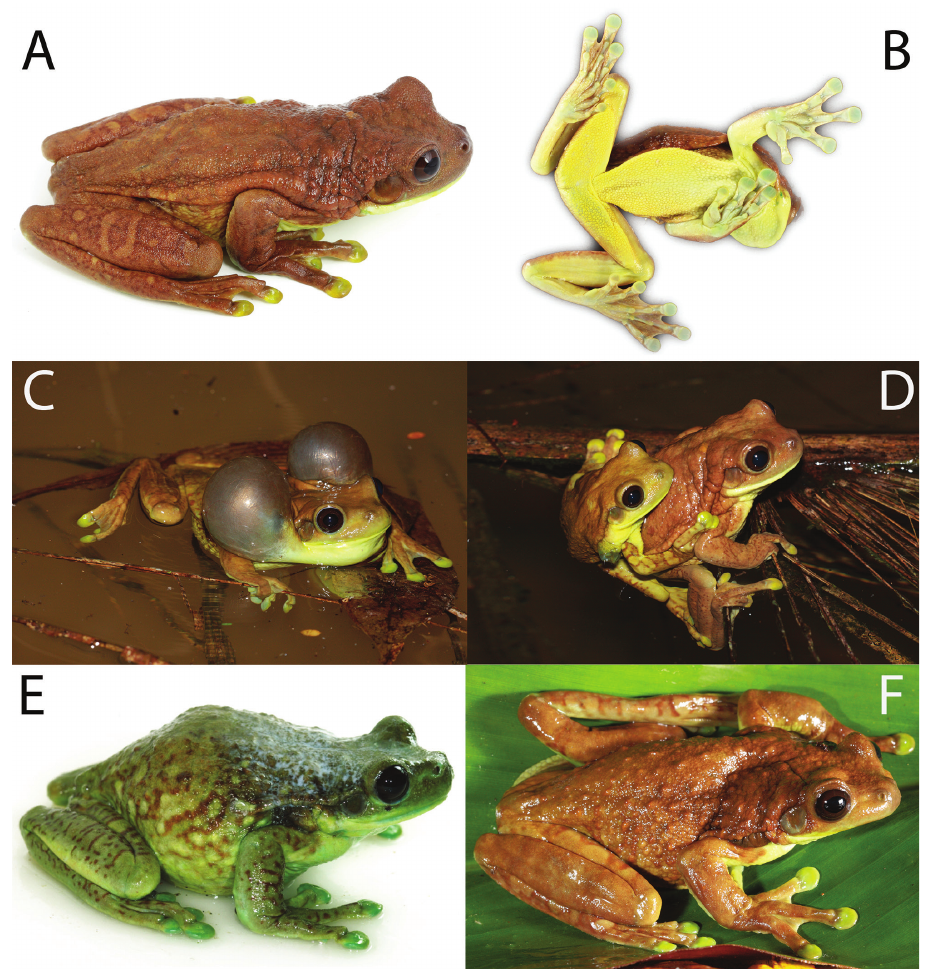
Figure 12. External morphology of Trachycephalus macrotis comb. n. A–B QCAZ 39565, adult female, SVL = 101.1 mm, Reserva Zanjarajuno, Ecuador C calling male, Reserva Zanjarajuno, Ecuador D am- plectant pair, QCAZ 39565, adult female (SVL = 101.12) and QCAZ 39566, adult male (SVL = 81.38), Reserva Zanjarajuno, Ecuador E CORBIDI 9544, adult male, (SVL = 82.9), Peru F QCAZ 43017, adult male, SVL = 91.5 mm, Parque Nacional Yasuní, km 22 Pompeya-Iro road, Ecuador. Photographs by S. R. Ron except for ( E ) by A.